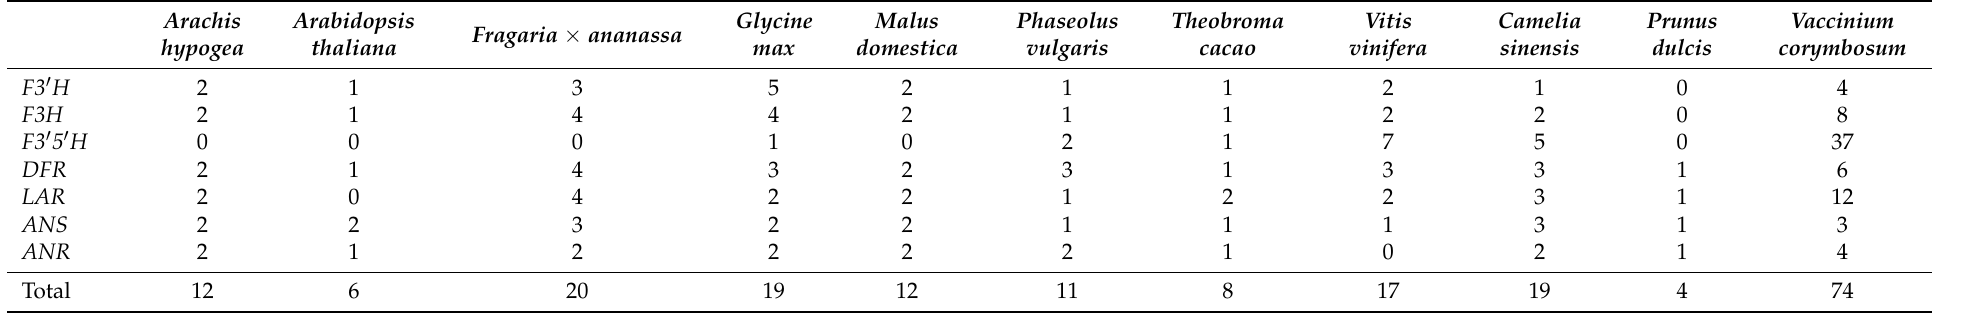
Table 3. Numbers of the seven orthologs encoding key enzymes that synthesize PAs identified in the reference genome of each